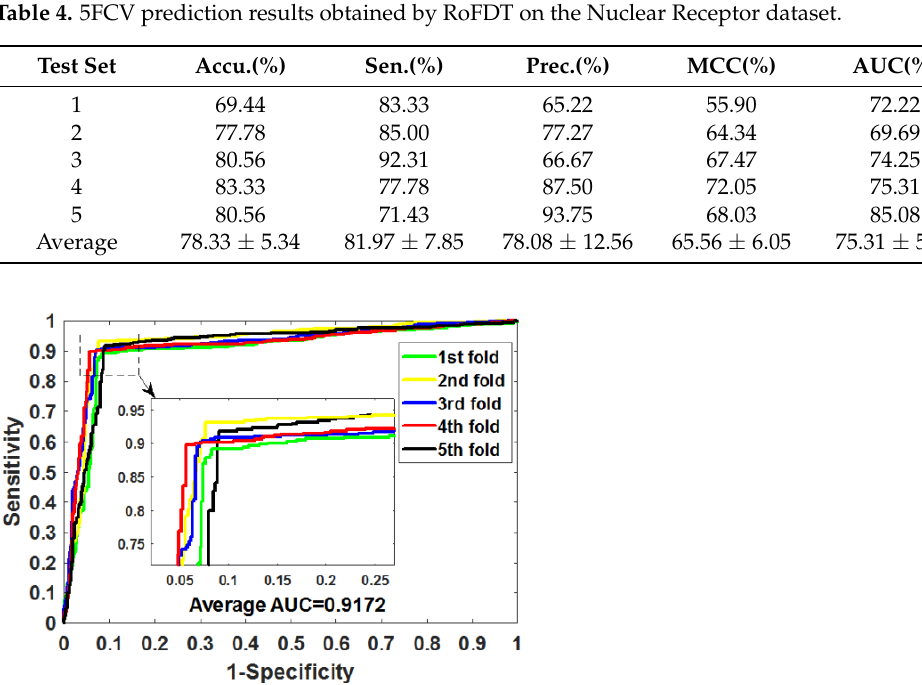
Figure 3. ROC curves of the 5FCV experiment acquired by RoFDT on the Enzyme dataset.